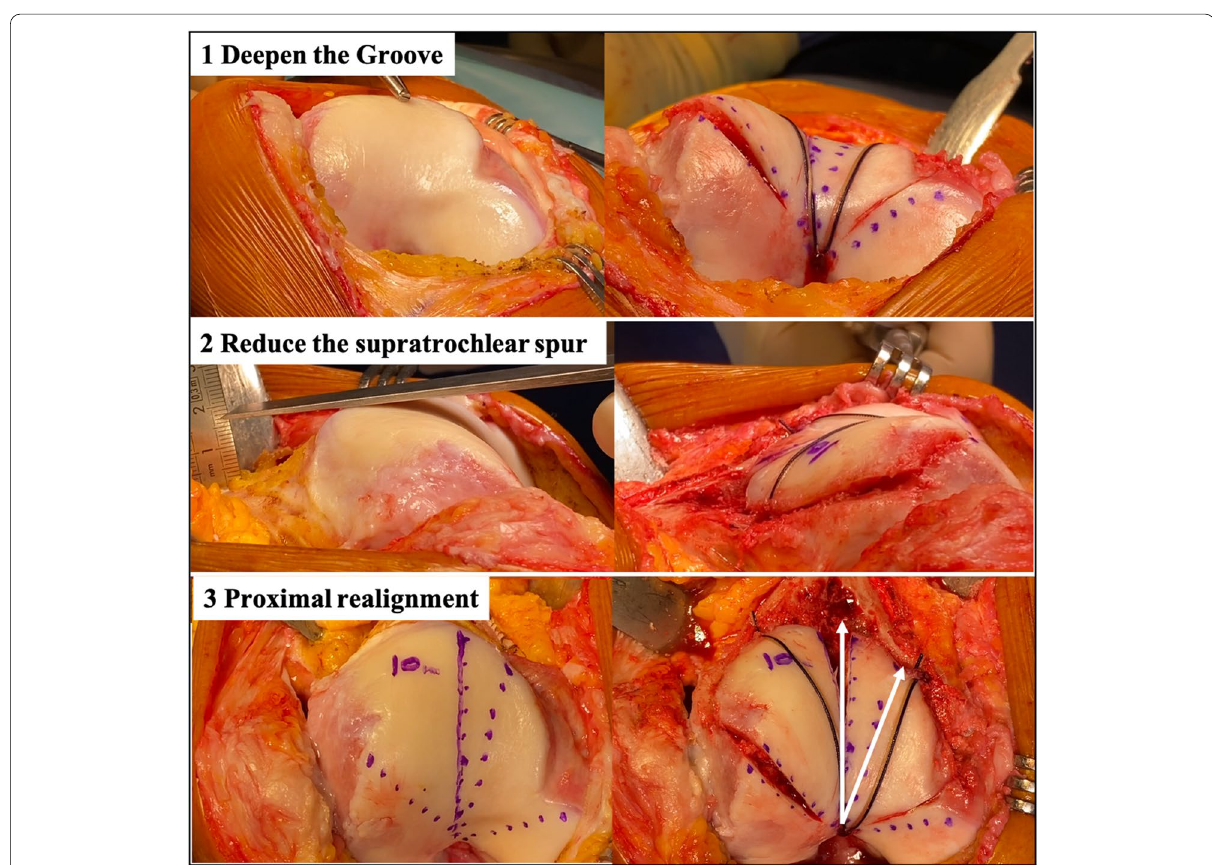
Fig. 7 Three goals of the deepening trochleoplasty: 1) Deepen the trochlea. 2) Reduce the supratrochlear spur and make the trochlea flushes with the femoral anterior cortex. 3) Proximal realignment with the new groove aligned with the anatomical femoral